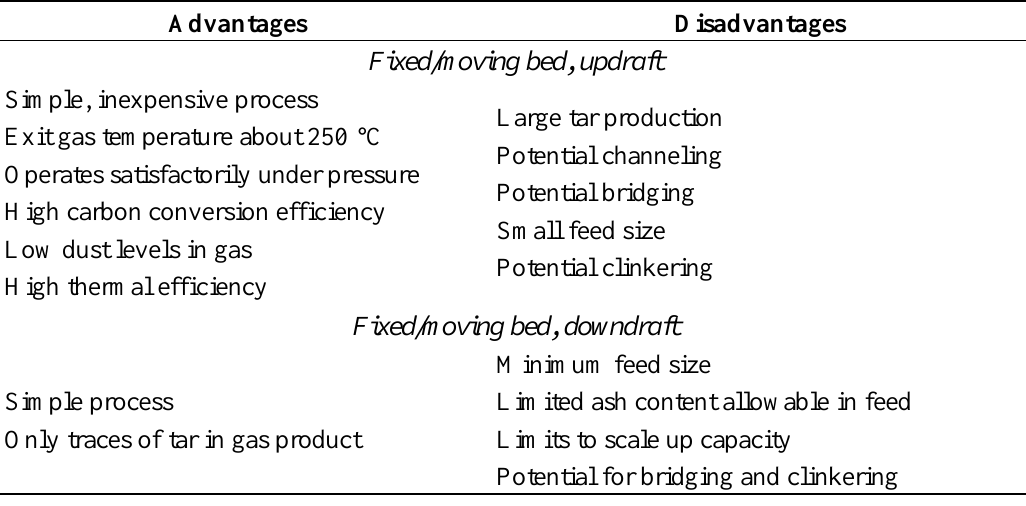
Table 2. Properties of selected gasification technologies